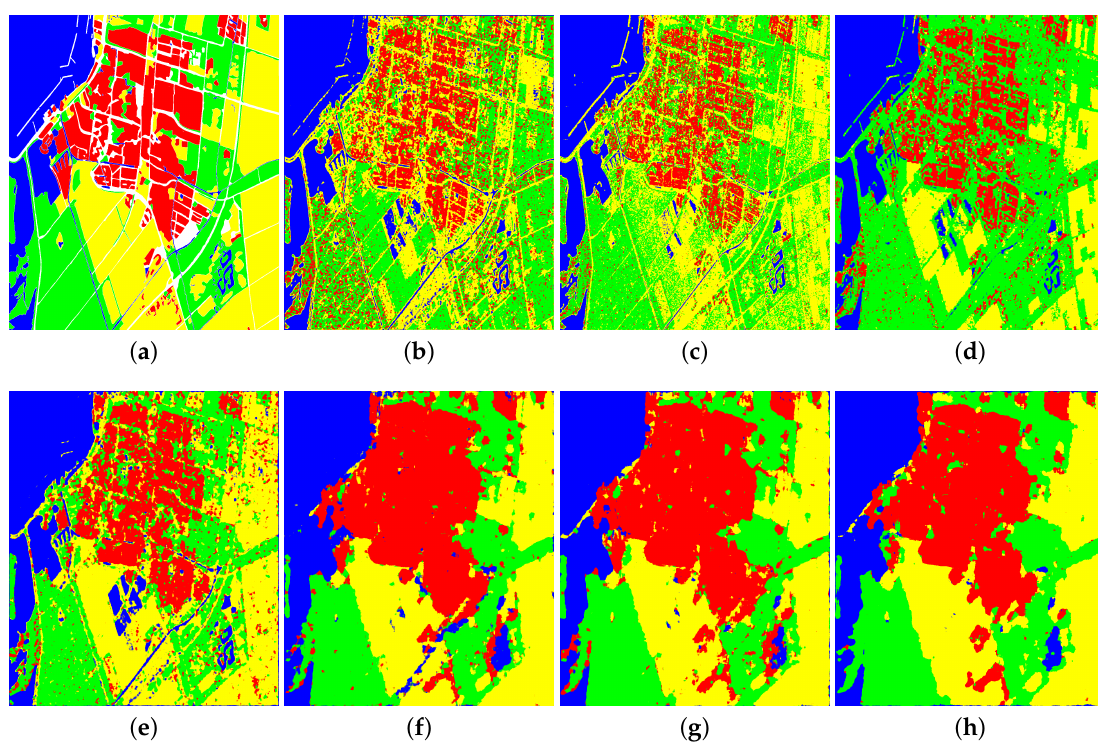
Figure 10. Classification results of RS-2 Flevoland dataset. ( a ) Ground truth map; ( b ) K-means; ( c ) Wishart; ( d ) ASC-S; ( e ) DAC; ( f ) DCCM; ( g ) DCCM+IIC; ( h )